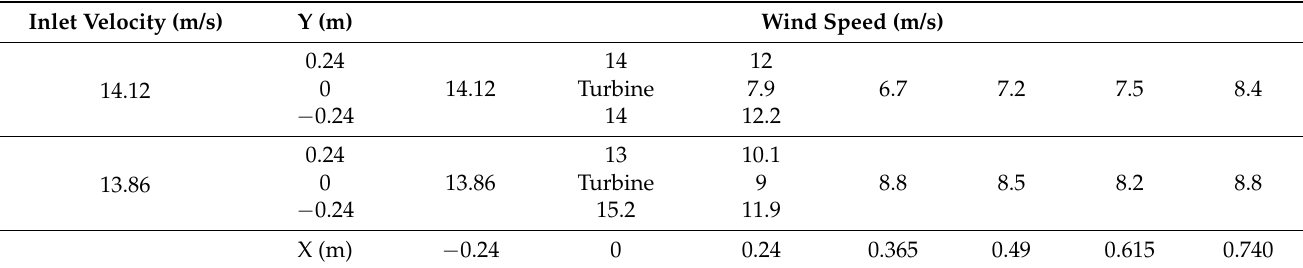
Table 6. Wind velocity contours from experiment at two inlet velocities.